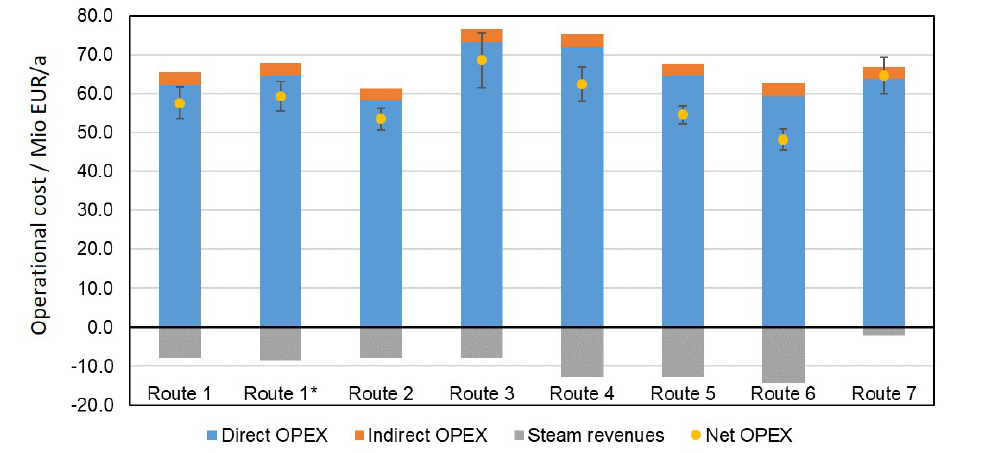
Figure 4. Operational cost/a of all routes for a plant size of 100 kt OME/a. The whiskers show the uncertainty in the operational